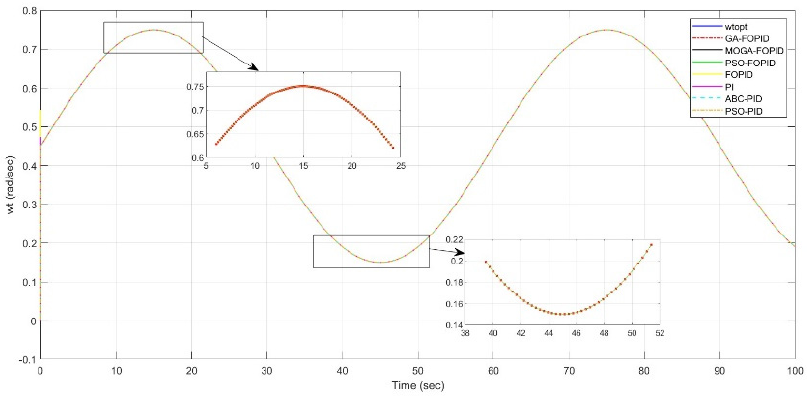
As another test, a sine wave was used, which had an amplitude of 0.3, a bias of 0.45, a frequency of 2 π /60 (rad/s) and a phase of 0 rad. As shown in Figure 8, all of the controllers displayed an ideal overlap on the reference signal.